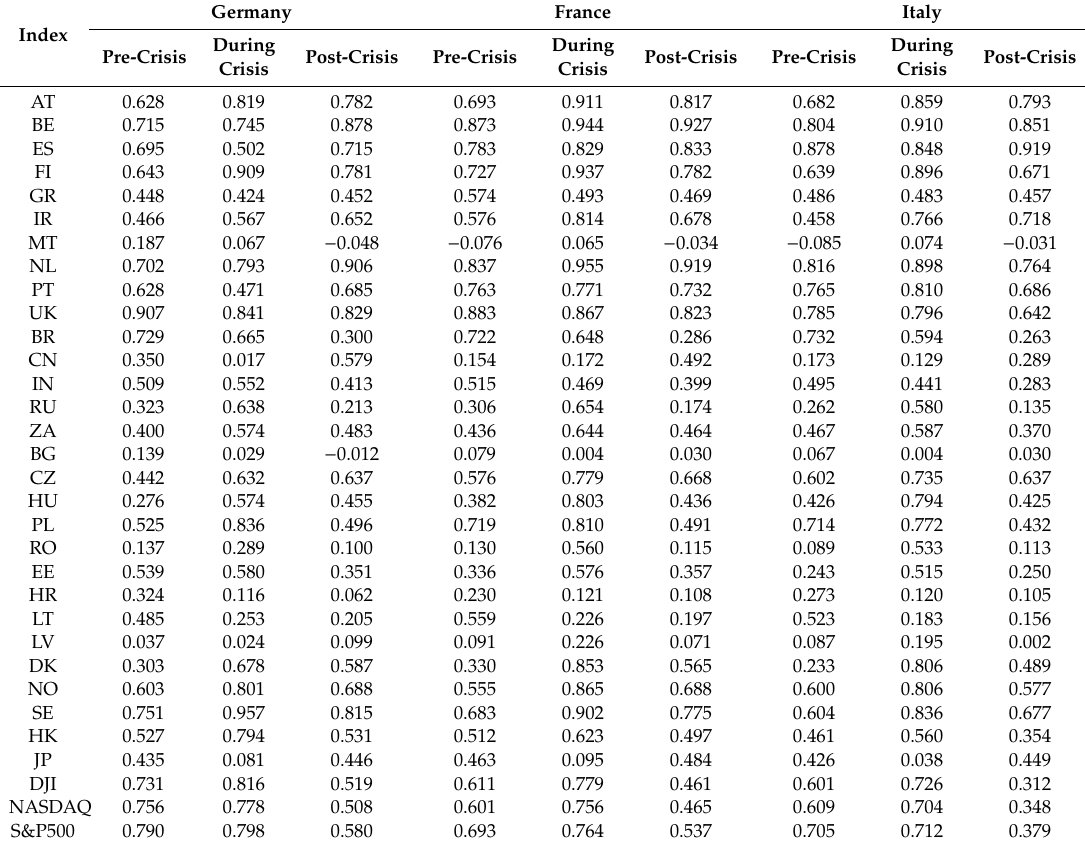
Table A3. Cross correlations coe ffi cients between lag predicted series during Pre-EZC. EZC and Post-EZC.